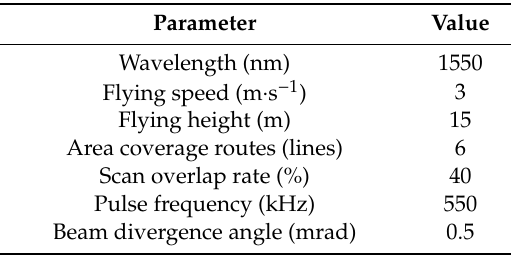
Figure 4. Schematic diagram of the RIEGLVUX-1UAV sensor. Table 2. Sensor related parameters.